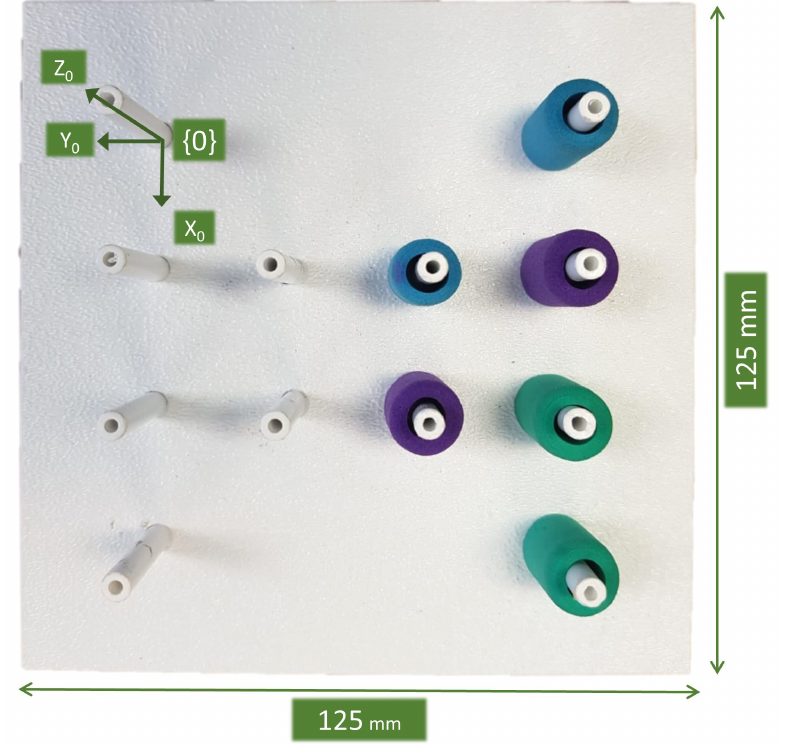
Figure 4. Experimental board. It had 12 pegs and the objective was to move cylindrical rubber rings from one peg to